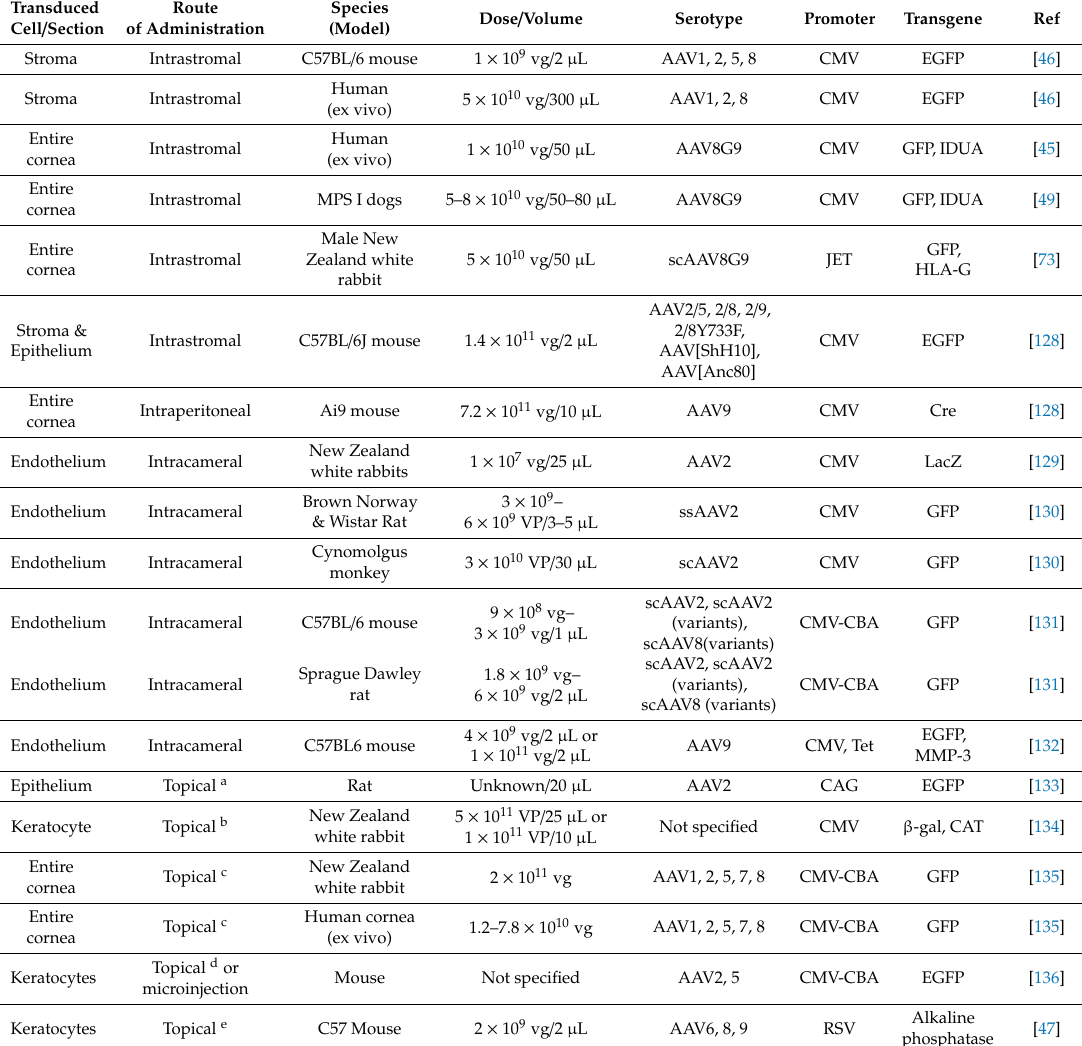
Table 2. Cornea route of administration and transduced cells /